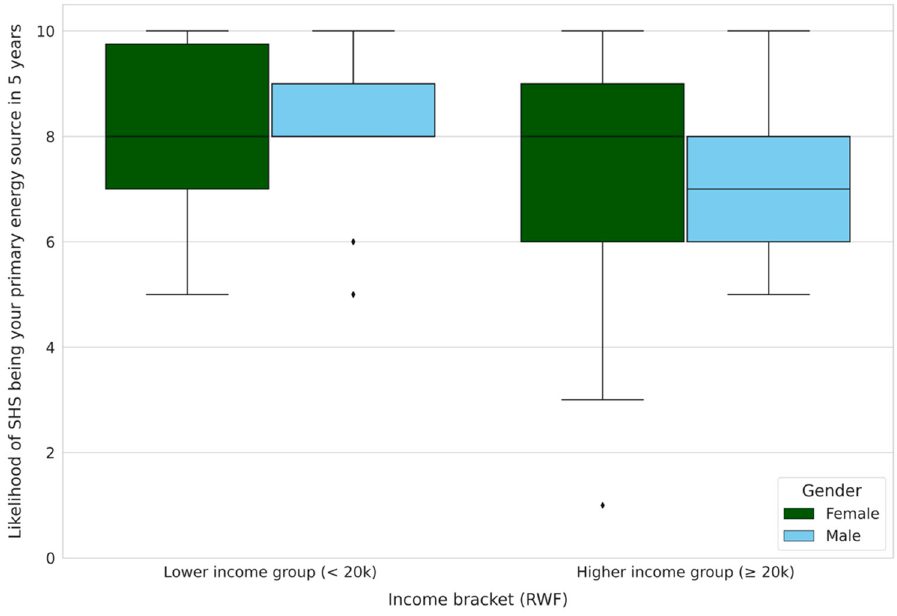
Figure 9. Likelihood of SHS as the primary energy source in 5 years’ time, by income and gender. Respondents that wanted a future grid connection were less likely (mean = 7.3) to